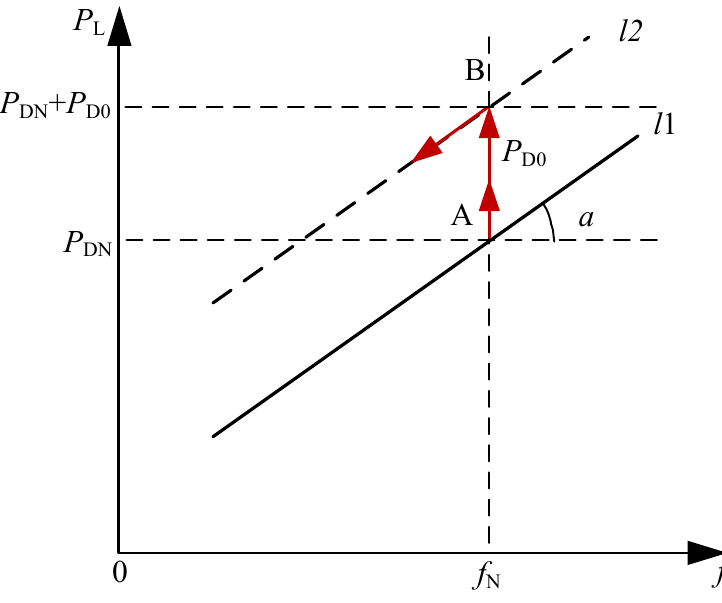
Figure 3. Power-frequency static characteristics of the load power.